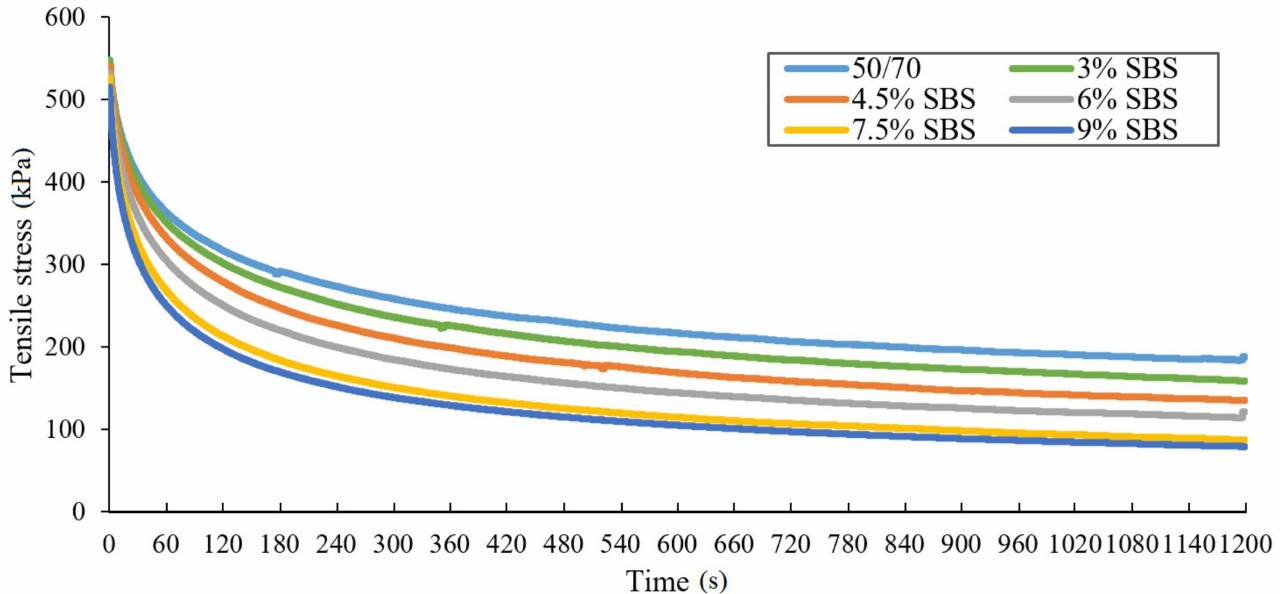
Figure 8. Relaxation curves of RTFOT aged bituminous binders obtained from the force-ductility-relaxation test conducted at − 16 ◦